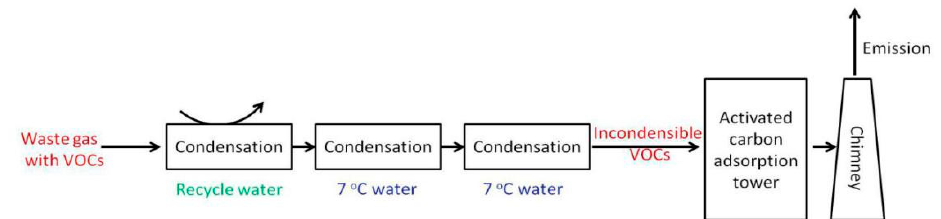
Figure 9. Representation of the VOC abatement process in a factory which produced cefuroxime axetil, cefuroxime sodium, and cefotaxime sodium. Reprinted with permission from [4], 2016, CNKI.